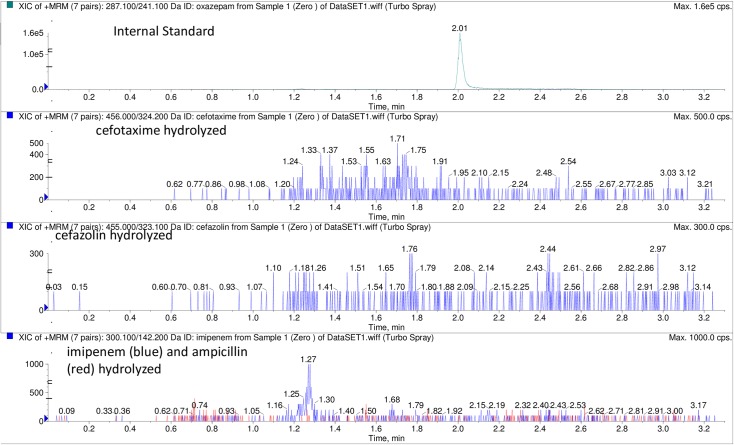
MRM (multiple reaction monitoring) chromatogram showing the profiles of the remaining amounts of cefazolin, cefotaxime, imipenem and ampicillin respectively after hydrolysis.The hydrolyzed profiles were demonstrated after incubation with a CPE isolate (sample 1). The profile of the internal standard (oxazepam) is shown above the profiles of the hydrolyzed antibiotic panel.